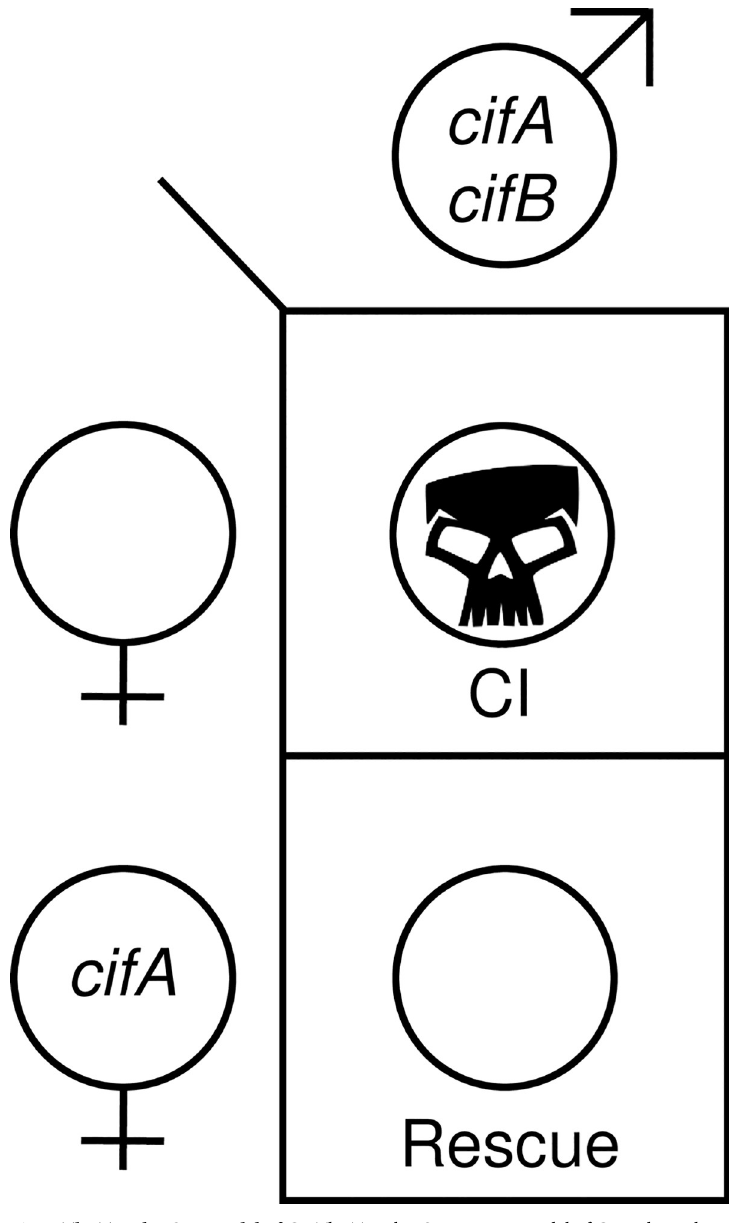
Fig 6. The Two-by-One model of CI. The Two-by-One genetic model of CI explains that cifA and cifB dual expression in uninfected males is necessary for embryonic lethality (CI; skull) when crossed to uninfected and non- expressing females. However, females expressing cifA can rescue CI in their offspring (rescue; open circle). Skull art is from vecteezy.com. Wolbachia and Cif products, and would induce the canonical cytological embryonic defects including delayed paternal nuclear envelope breakdown, slowed Cdk1 activation, a failure of maternal histones to deposit onto the paternal genome, stalled or failed replication of the paternal DNA, a failure of paternal chromosomes to segregate, and later stage regional mitotic failures [7,38,60,61,64–67], or they are reversed by female-derived rescue factors. Leading HM models are the Mistiming [60,61] and Goalkeeper [63] models that leverage findings that male